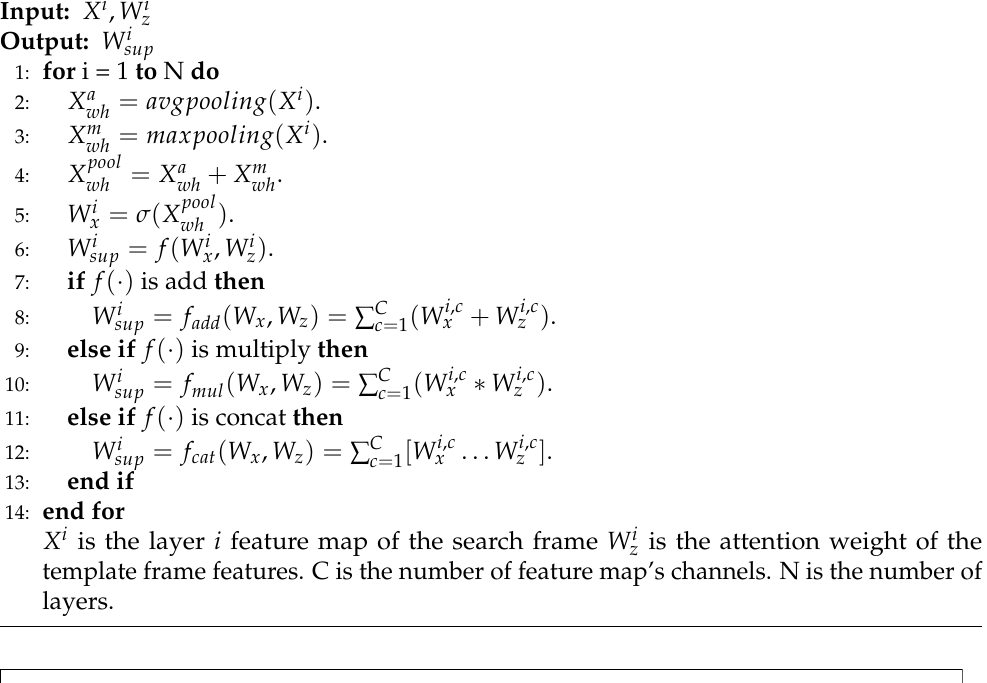
Algorithm 1 Compensated Attention Strategy for Searching Branches.